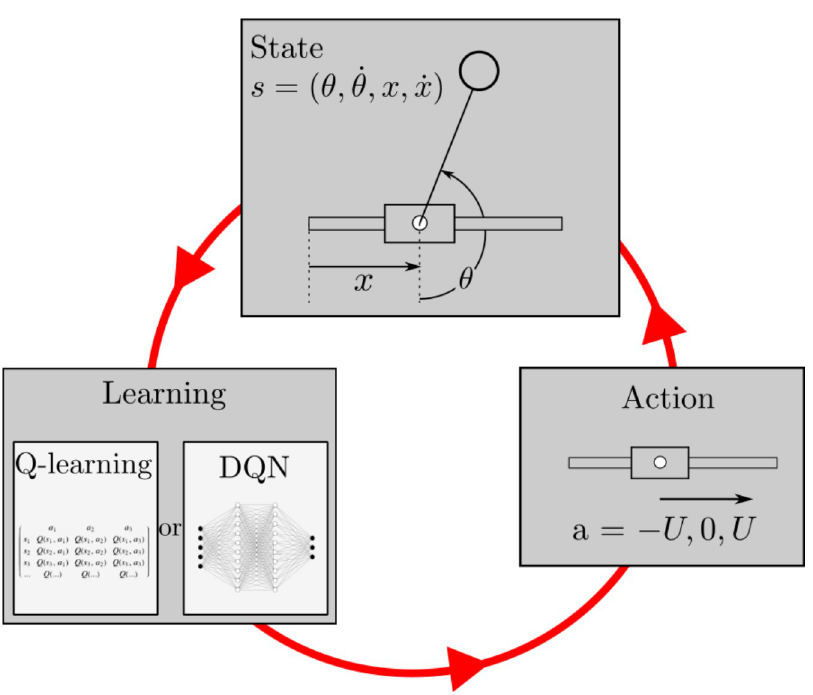
Fig 2. RL learning process. The state of environment s is measured and given to the agent. The agent updates it policy and accordingly choose the action a for the next step among − U , 0 or U . After sampling time, the state s evolves and the cycle continues. In our case, s ¼ ð y ; _ y ; x ; _ x Þ . The policy is updated by updating the action-value function for Q-Learning and DQN, using a so-called Q-table and artificial neural networks,